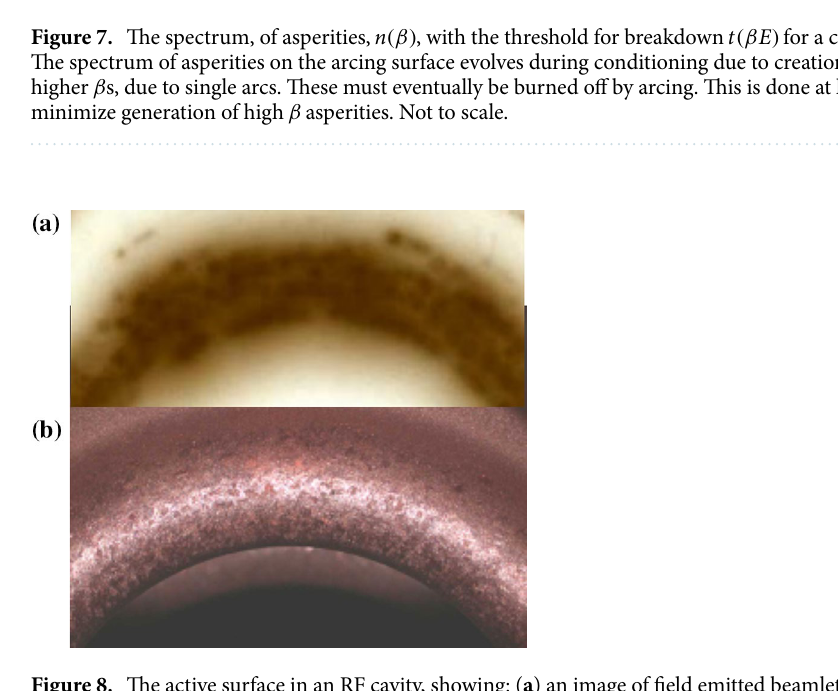
Figure 8. The active surface in an RF cavity, showing: ( a ) an image of field emitted beamlets from an 8 cm diameter iris in a fully conditioned cavity in a 3 T magnetic field, showing that the surface of the irises is covered in high field enhancement asperities, and the active sites are at essentially equal local field enhancements, and ( b ) an iris in the 6 cell cavity showing arc damage spots about 500 µ m in in diameter. The apparatus is described in Ref. 9 . The image in Fig. 5 is seen in the center of one of these spots. Experimental details are presented in Refs. 9,39